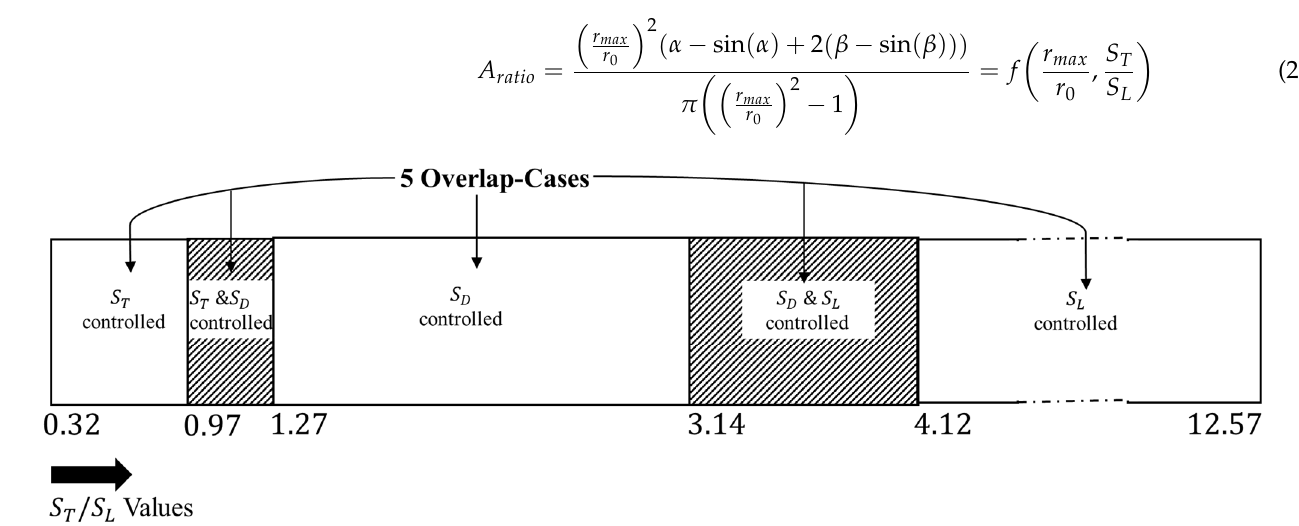
Figure 6. Different overlap cases governed by specific 𝑆 (cid:3021) /𝑆 (cid:3013) values and controlled directions. The geometric behavior of the overlap regions is quantified by the ratio ( 𝐴 (cid:3045)(cid:3028)(cid:3047)(cid:3036)(cid:3042) ) of the PCM overlap region ( 𝐴 (cid:3042)(cid:3049)(cid:3032)(cid:3045)(cid:3039)(cid:3028)(cid:3043) (cid:3404) 2𝐴 (cid:2869) (cid:3397) 𝐴 (cid:2870) ) to the total PCM region ( 𝐴 (cid:3045)(cid:3028)(cid:3031)(cid:3036)(cid:3028)(cid:3039) ). A detailed mathematical analysis is carried out in Appendix B. Thus, the geometric parameter 𝐴 (cid:3045)(cid:3028)(cid:3047)(cid:3036)(cid:3042) can be determined by knowing the 𝑆 (cid:3021) /𝑆 (cid:3013) and 𝑟 (cid:3040)(cid:3028)(cid:3051) /𝑟 (cid:2868) values, as obtained from Equation (A12) in Appendix B and as shown below.